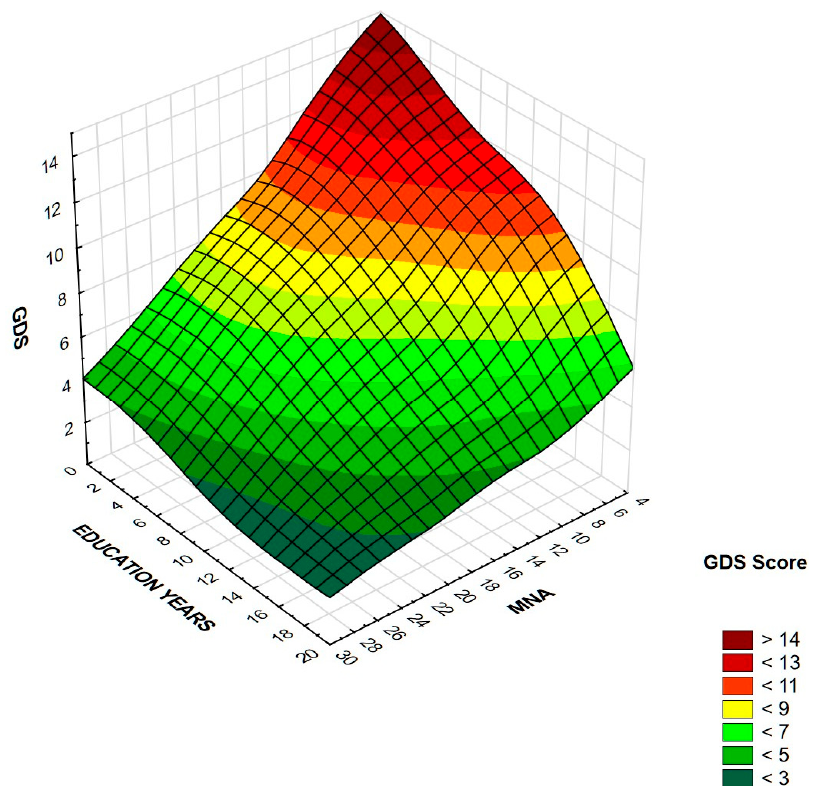
Figure 2. Association between GDS score, education years, and MNA in women. Higher GDS is associated with lower education level and lower MNA score in this group.